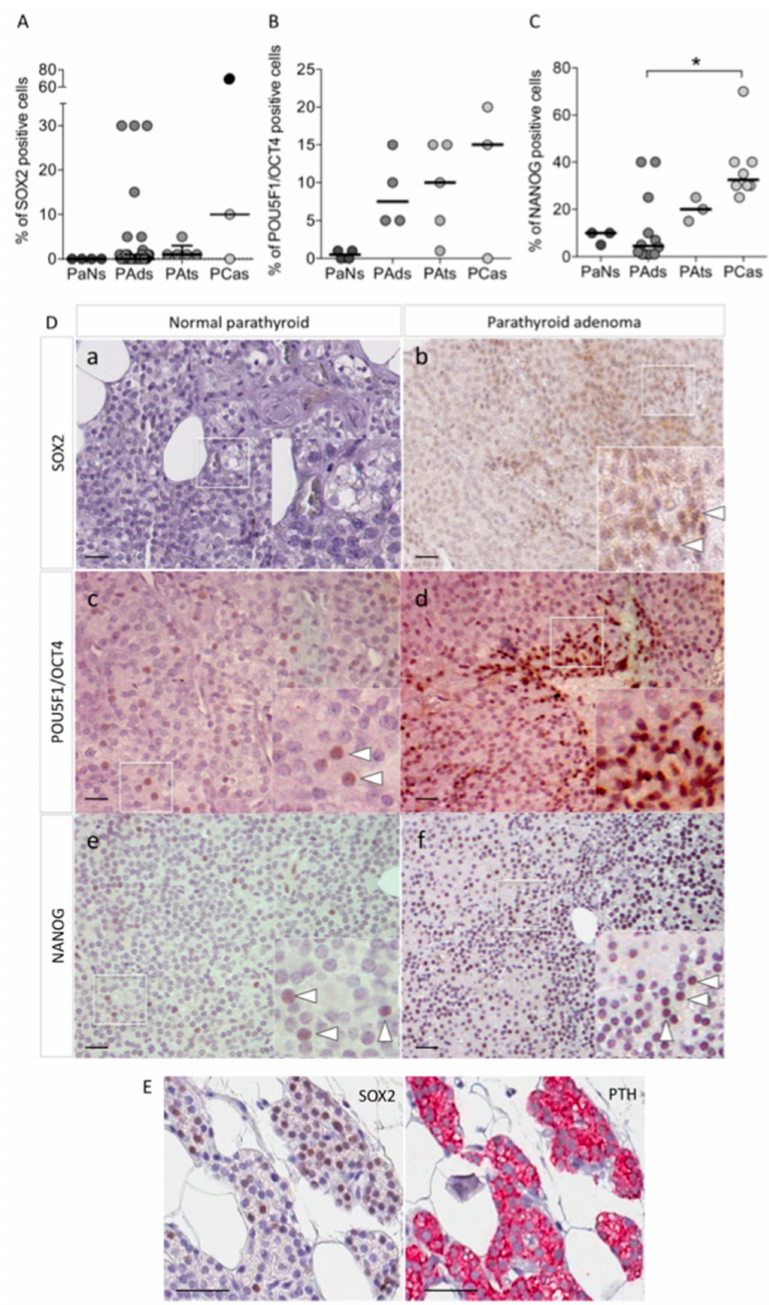
Figure 1. Expression of core stem genes in human parathyroid tissues. ( A ) Percentage of cells expressing SOX2 detected by immunohistochemistry (IHC) in parathyroid tissues; black circle represents a metastatic PCa. PaNs, normal parathyroid glands; PAds, parathyroid adenomas; PAts, parathyroid atypical adenomas; PCas, parathyroid carcinomas. ( B ) Percentage of cells expressing POU5F1/OCT4 detected by IHC in parathyroid tissues. ( C ) Percentage of cells expressing NANOG detected by IHC in parathyroid tissues; * p = 0.005 vs. PAds by Kruskall–Wallis test adjusted for multiple comparison. ( D ) Normal parathyroid cells did not show specific nuclear immunostaining for SOX2 ( a ); PAds FFPE sections showed a subset of cells with weakly positive nuclear staining for SOX2 ( b ). Nuclear staining for POU5F1/OCT4 was detected in rare cells in normal parathyroid glands ( c ) (white heads of arrow), while POU5F1/OCT4 -expressing cells were detected in cell clusters in PAds ( d ). Nuclear staining for NANOG was detected in rare cells in normal parathyroid glands ( e ) (white heads of arrow), and in a few PAds cells ( f ). All representative sections were acquired at 40 × magnification and scale bars represent 200 nm. Inserts show specific nuclear staining. ( E ) Immunostaining of contiguous sections showing SOX2 -expressing cells ( left , brown) and the corresponding PTH staining ( right , red); scale bars represent 200